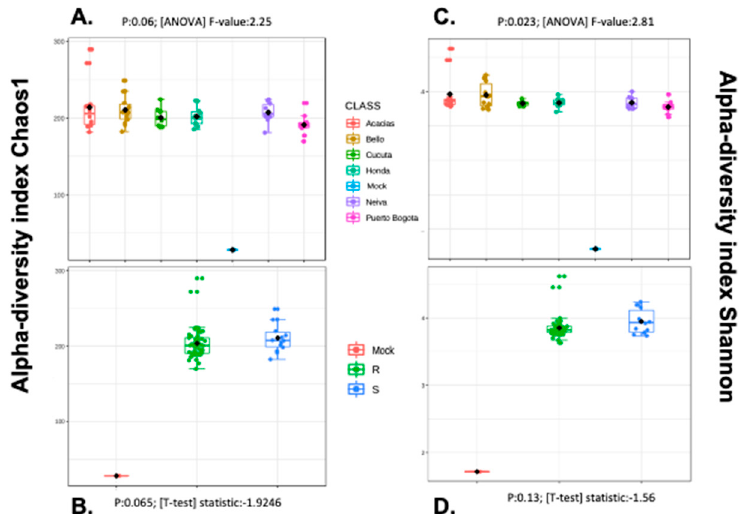
Figure 4. Alpha diversity (Chao1 and Shannon indices) among six Colombian Aedes aegypti populations. ( A ) and ( C ): Alpha diversity among geographical origins. ( B ) and ( D ): Alpha diversity between lambda-cyhalothrin resistant (R) and susceptible (S) mosquitoes. The mock sample corresponds to samples of known bacteria used as controls during DNA extraction procedures and sequencing.